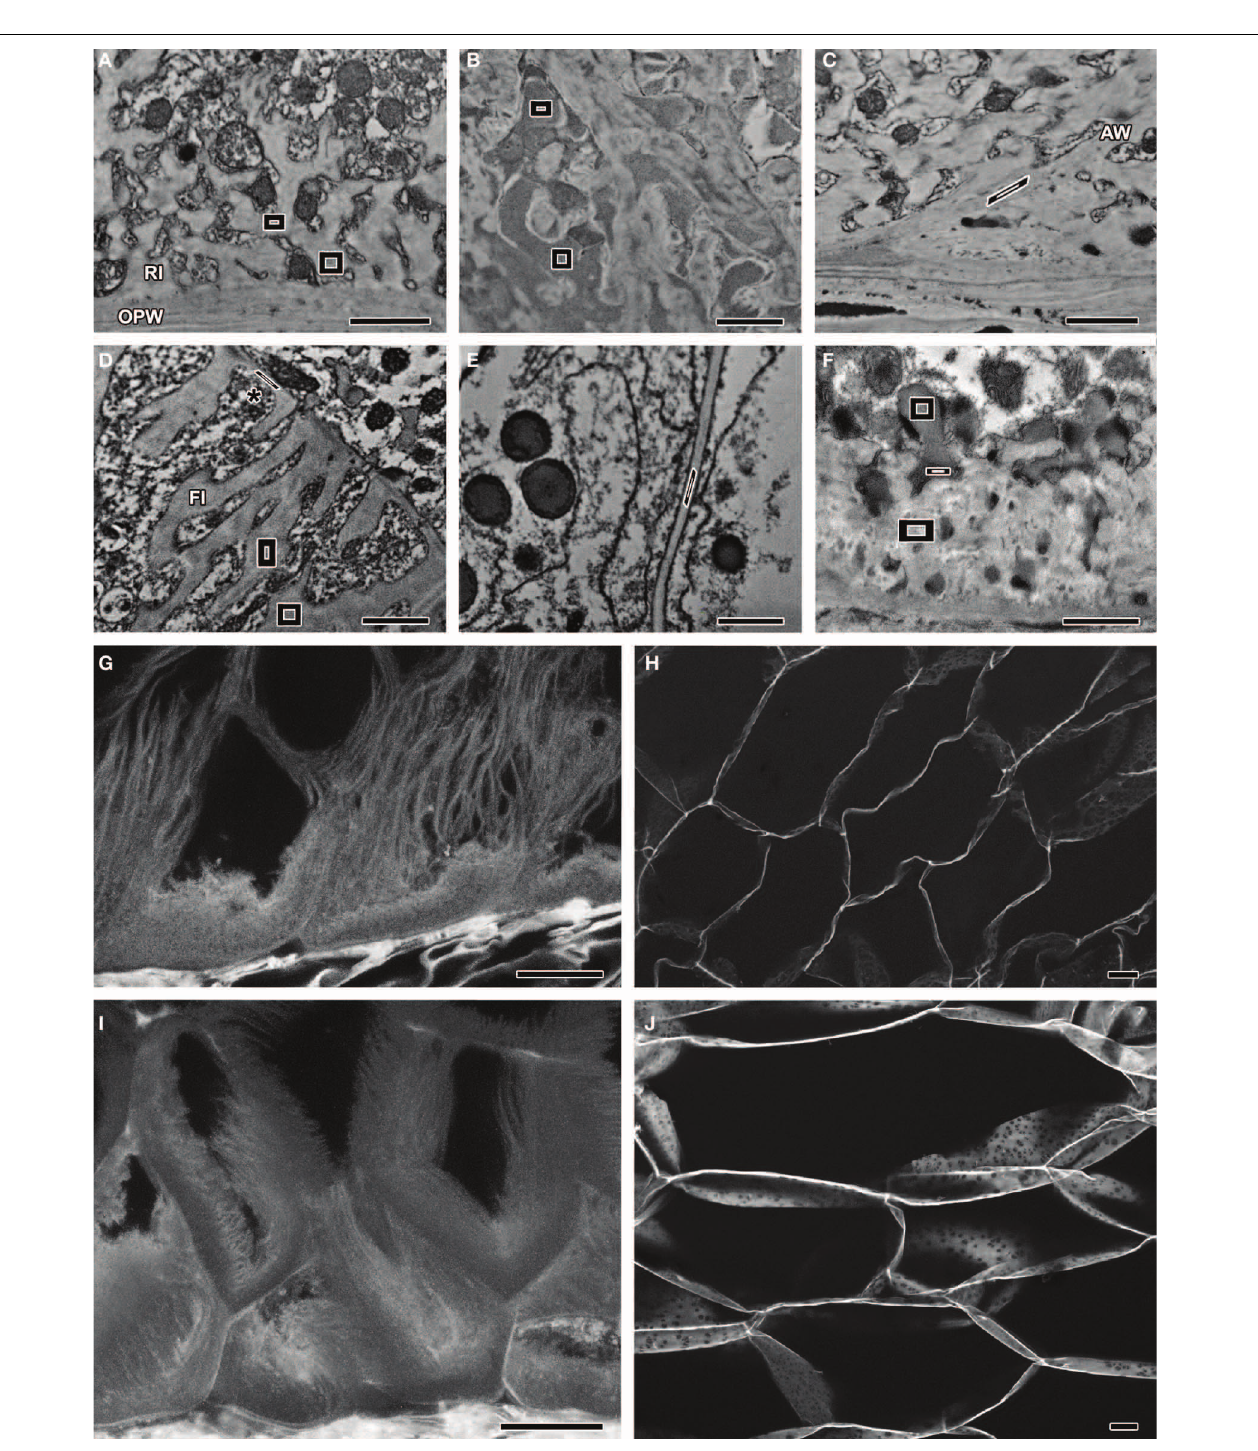
FIGURE 1 | Images obtained by TEM-EDS (A–E) and TEM (F) of samples stained with KMnO 4 . Polygons represent the boundaries of EDS readings in each sample. (G–J) CLSM images of acriflavine-stained samples. (A) MBETCs at 12 DAP – readings were obtained from the reticulate ingrowths. (B) MBETCs at 12 DAP – readings were obtained from vesicles adjacent to reticulate ingrowths. (C) MBETCs at 12 DAP – readings were obtained from anticlinal walls. (D) MBETCs at 20 DAP –